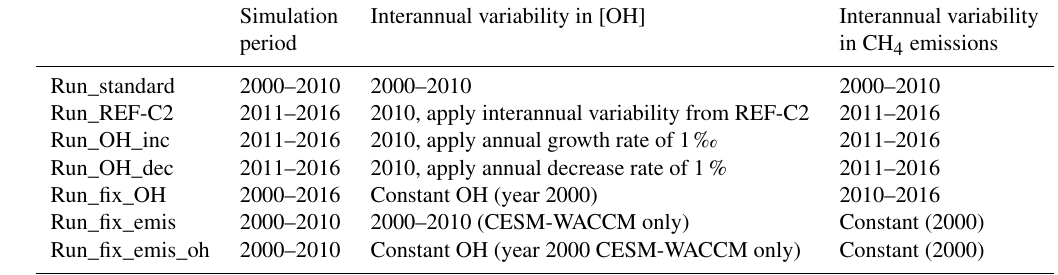
Table 2. List of LMDz experiments and model setups.